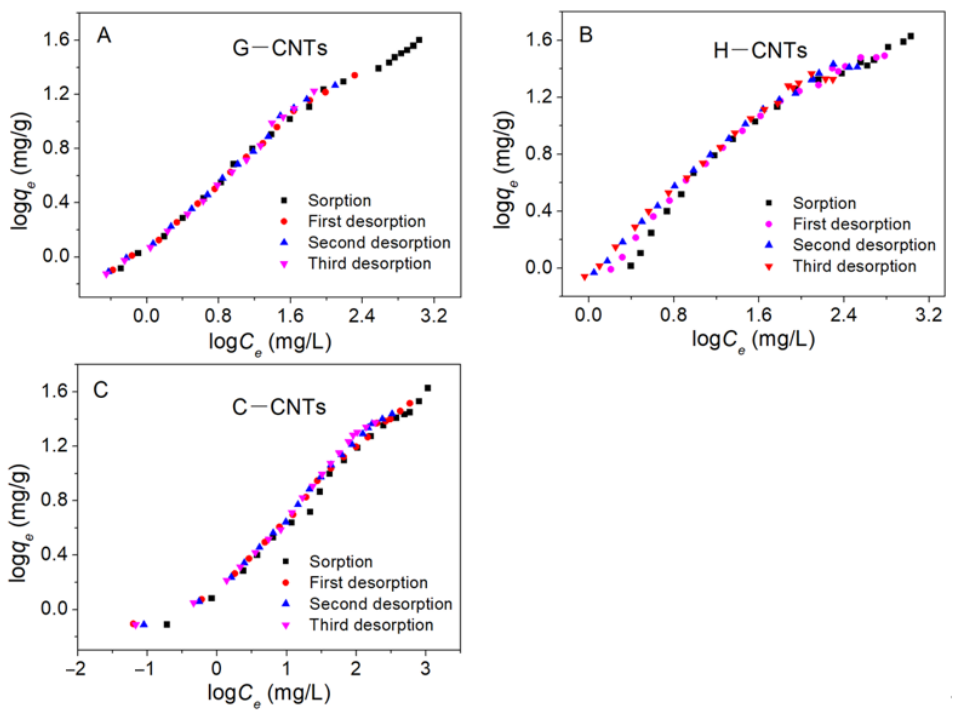
Figure 1. Adsorption − desorption isotherms of nitrobenzene by the three functionalized carbon nanotubes: ( A ) G − CNTs; ( B ) H − CNTs; and ( C ) C − CNTs. nanotubes: ( A ) G − CNTs; ( B ) H − CNTs; and ( C ) C −